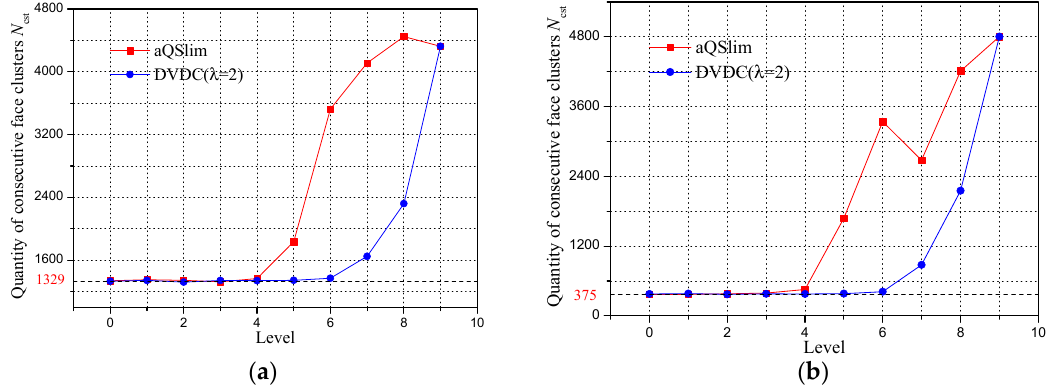
Figure 8. The number of consecutive surface clusters using the extraction of planar surface extraction compared with simplified surfaces using dihedral angles of edges as rulers. It is seen that different simplification algorithms and different input surfaces influence the appropriate simplification rate that can use dihedral angles as rulers. For example, it is suitable for scenery 2 below level 4 with aQSlim as the simplification algorithm. ( a ) Scenery 1; ( b ) Scenery 2.